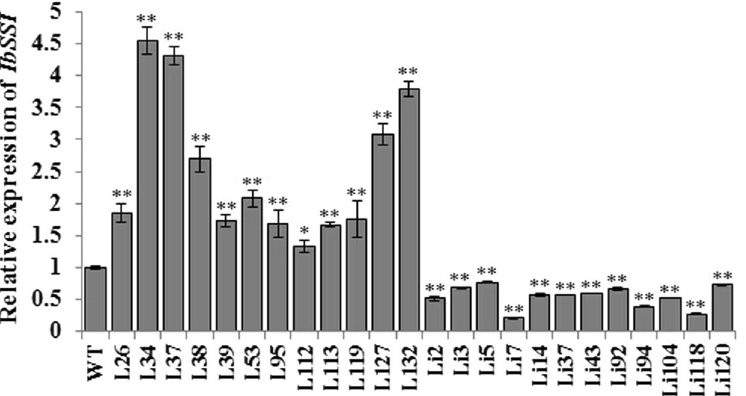
Figure 4. Transcript levels of IbSSI in the storage roots of the 24 transgenic lines and WT. The results are expressed as relative values with respect to WT, which was set to 1.0. Data are presented as the mean ± SD (n = 3). * And ** Indicate a significant difference versus the WT at P < 0.05 and < 0.01, respectively, based on Student’s t -test.